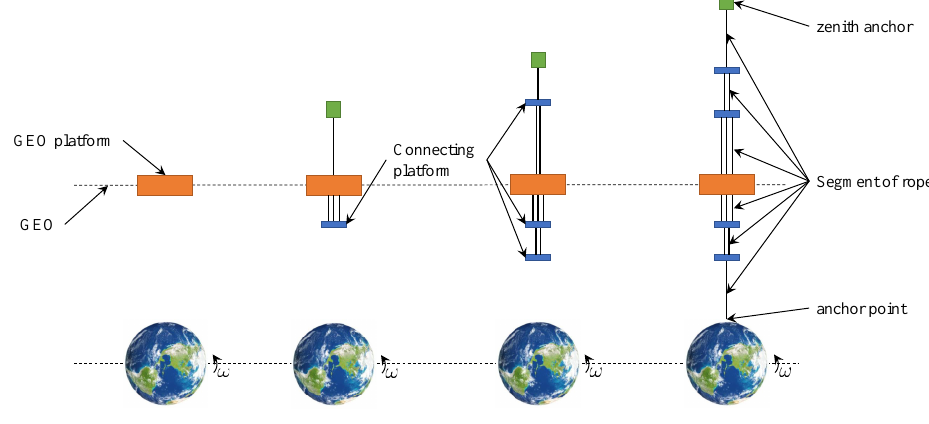
Figure 4. Build stage of segmented space elevator system